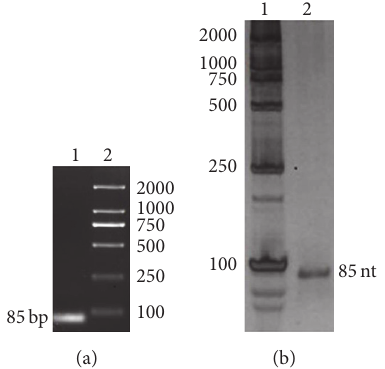
Figure 1: Identification of dsDNA and ssDNA using electrophoresis. (a) 2% sepharose gel electrophoresis of the 85-bp dsDNA amplified by symmetric PCR. Lane 1 is the 85-bp dsDNA, and lane 2 is the DL2000 DNA Marker; (b) 8% denaturing urea gel electrophoresis of ssDNA. Lane 1 is the DL2000 DNA Marker, and lane 2 is the 85-nt ssDNA amplified by asymmetric PCR.